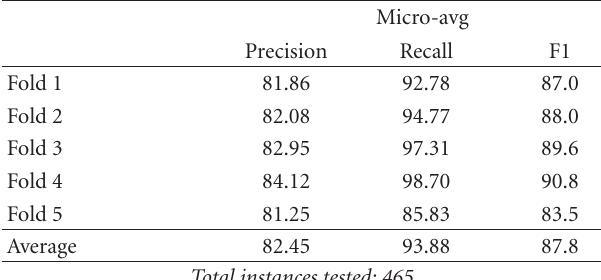
Table 8: Precision, recall, and F1 results of our method on the fivefold in the species disambiguation